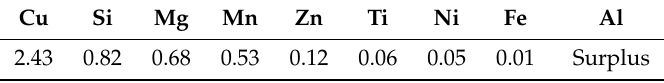
Table 1. Chemical composition of 2A50 aluminum alloy (wt.%).